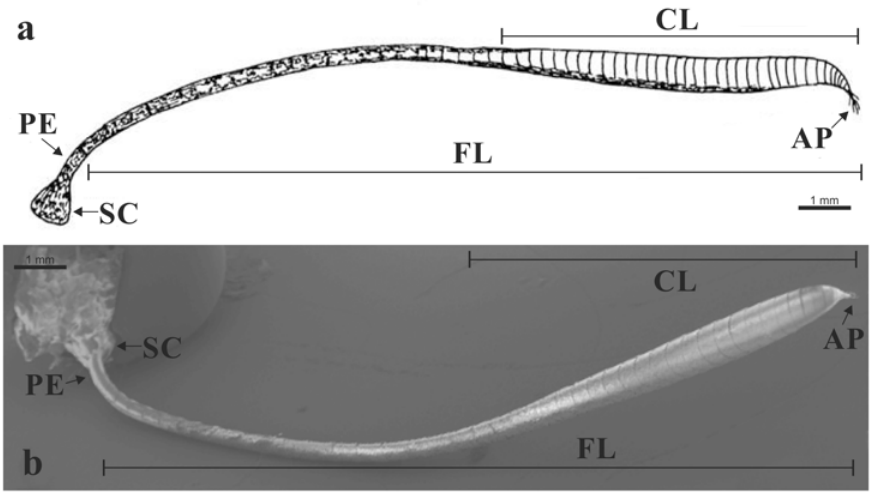
Fig 1. Antenna of Paysandisia archon . (a) Schematic drawing; (b) SEM overall view of a male antenna. [SC] scape; [PE] pedicel; [FL] flagellum; [CL] club; [AP] apiculus. Scale bars: 1 mm (a).